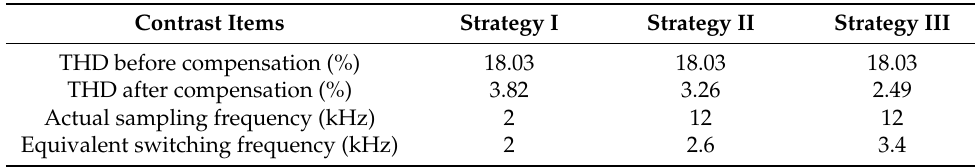
Table 2. Quantitative comparison of the effects of three control